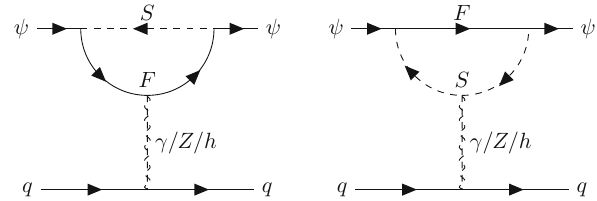
Fig. 1 One-looppenguindiagramsforfermionicsingletDMscattering offnuclei.Theyaregeneratedwithuptotwoheavyparticlesfromadark sector(ascalar S andafermion F ).Thephotonand Z bosonarecoupled to the new fermion (left diagram) or the new scalar (right diagram). For minimal models with one fermion the Higgs boson h only couples to the scalar S , but SM fermions in the loop also lead to a Higgs penguin diagram where the SM Higgs boson is attached to the fermion line. The possible quantum numbers of the dark particles are given in Table